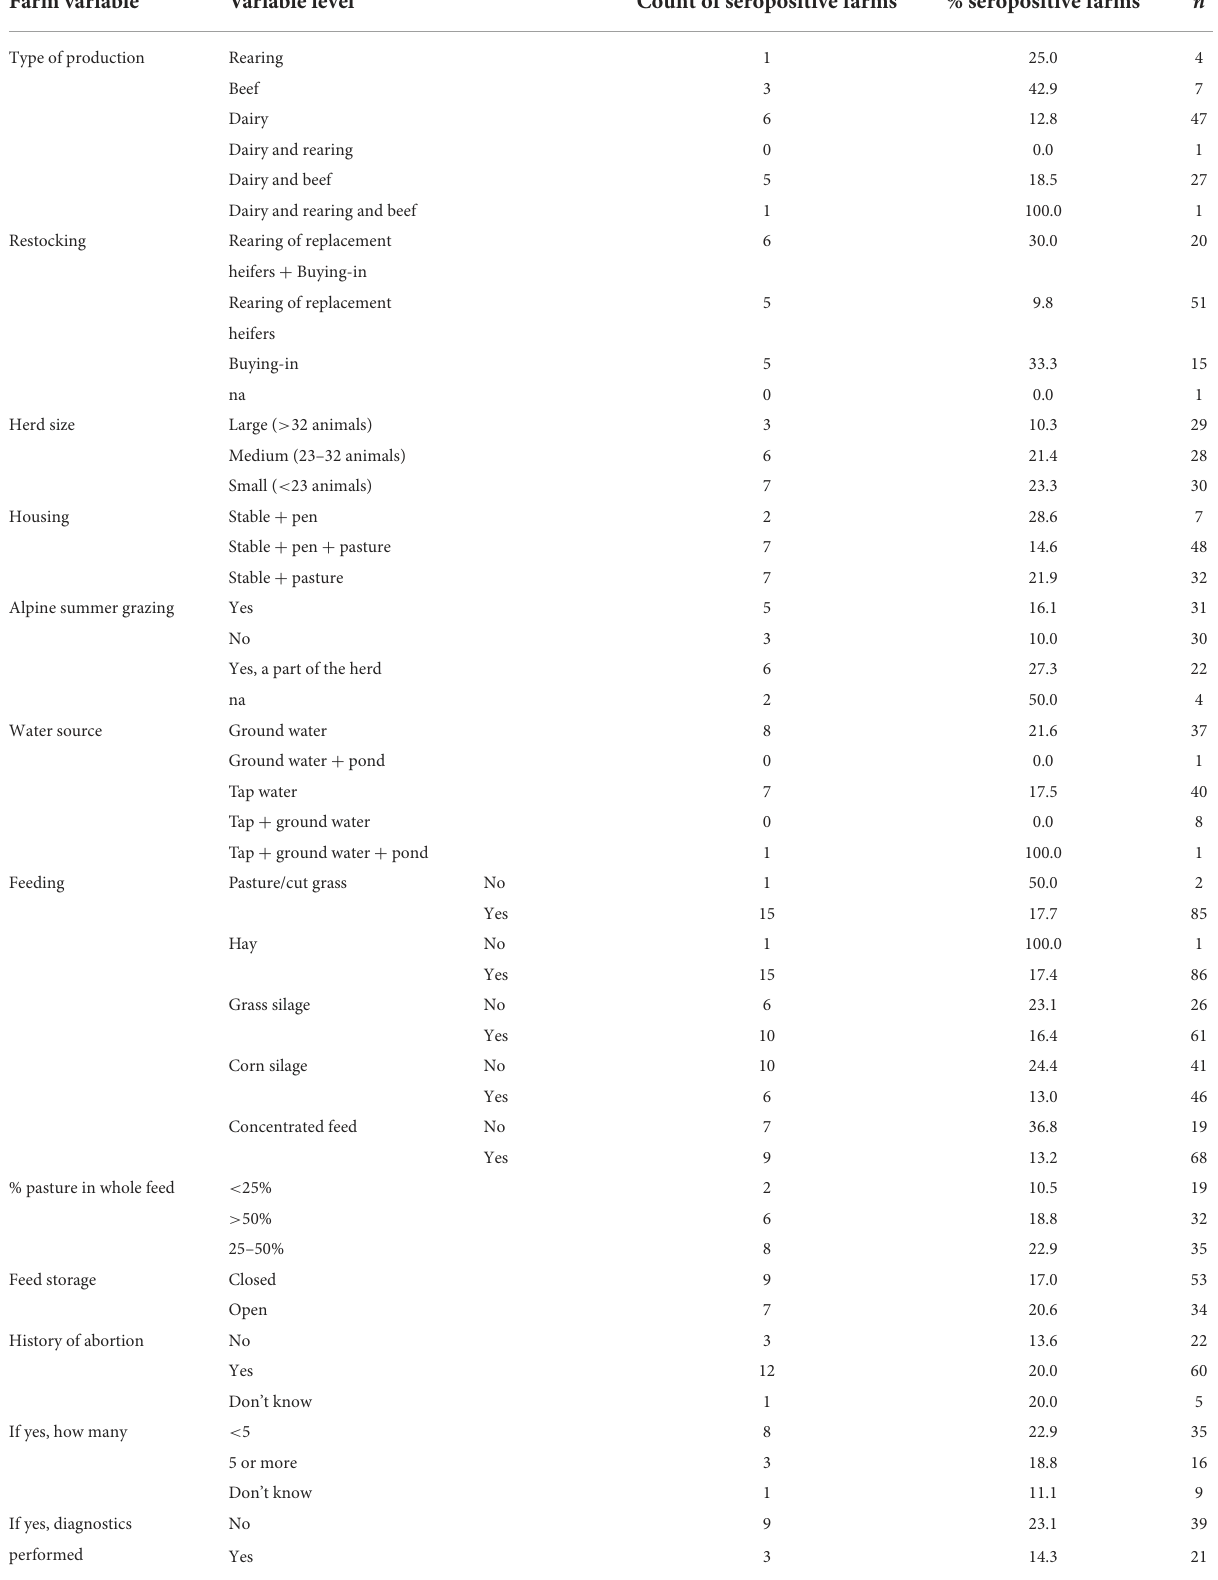
TABLE 3 Summary of farming parameters based on answers in the questionnaire and farm serostatus. Farm